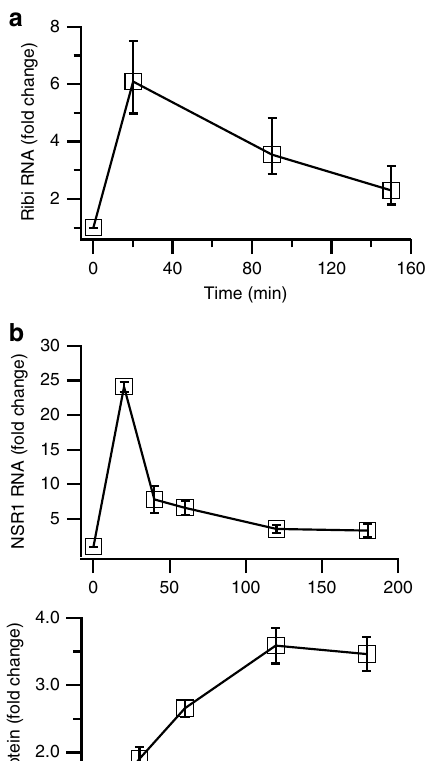
Fig. 2 Dynamics of protein and ribosome gene expression. a Average expression of Ribi genes from Group I in Fig. 1 (for top 300 out of 341 genes). Error bars show the expression of genes at the 25th and 75th percentiles. b Fold change in NSR1 mRNA expression (top panel) and Nsr1 protein level (bottom panel) after introduction of glucose to cells growing in glycerol, as measured by qPCR and western blotting, respectively (see Supplementary Fig. 3 for raw data). The data show the average and standard deviation from three biological replicates, normalized based on the Nsr1 protein or RNA levels at time zero. c Simulations of NSR1 mRNA (solid lines) and protein (dotted lines) synthesis as described in the text for different levels of mRNA production (color